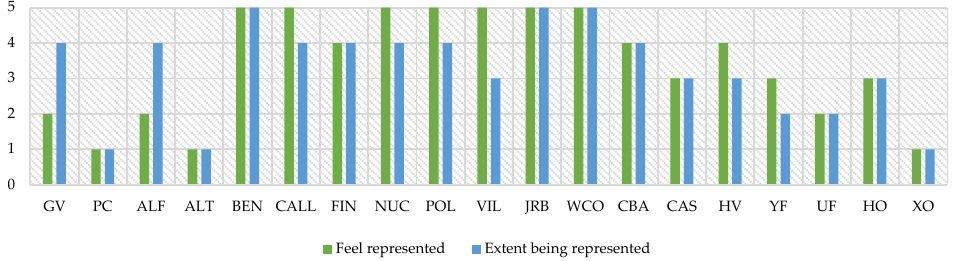
Figure 7. Feeling represented and extension. Legend: 0 (do not know/no answer), 1 (not represented at all/minimum), 2 (not enough represented/low), 3 (partially represented/medium), 4 (quite represented/high), and 5 (absolutely represented/highest). Note: government officials (GV, PC, ALF, ALT, BEN, CALL, FIN, NUC, POL and VIL); water managers (JRB and WCO); agricultural sector (CBA, CAS, HV, YF, UF); tourism sector (HO); environmental sector (XO).